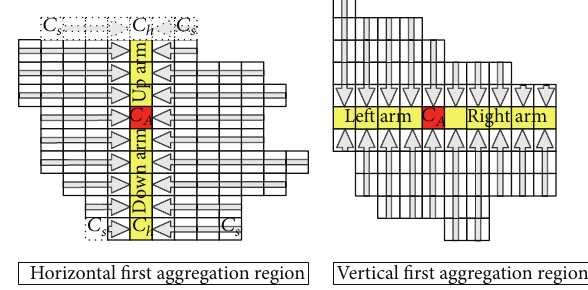
Figure 2: Illustration of cross-based cost aggregation regions: left projecting all horizontal arms on the vertical arms of a pixel, right projecting vertical arms on the horizontal arms of a